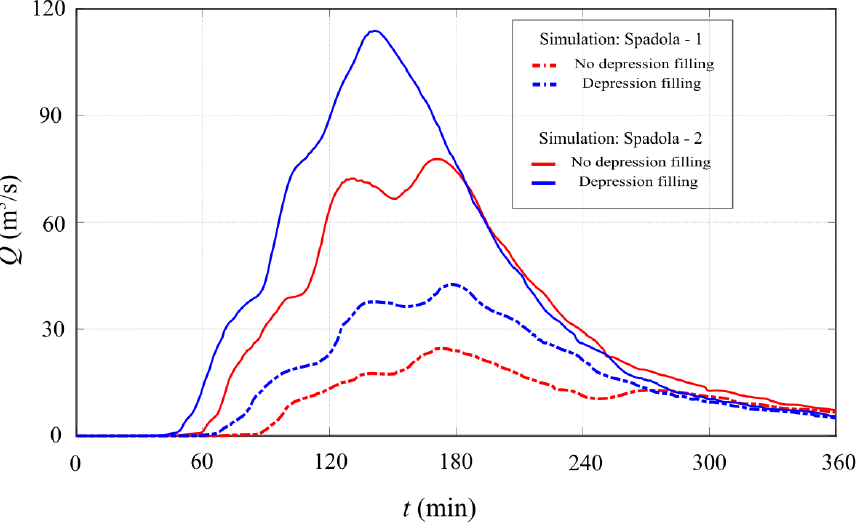
Figure 7. Spadola Watershed: influence of depression filling on the discharge hydrographs related to different rainfall scenarios.